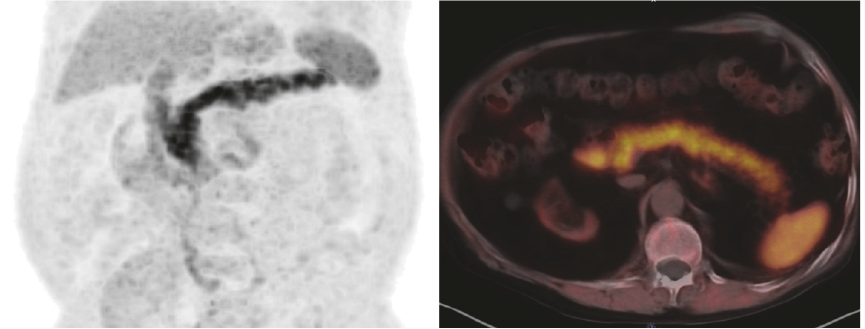
Figure 1: The dominant organ uptake of 11 C-acetate is seen in the pancreas.